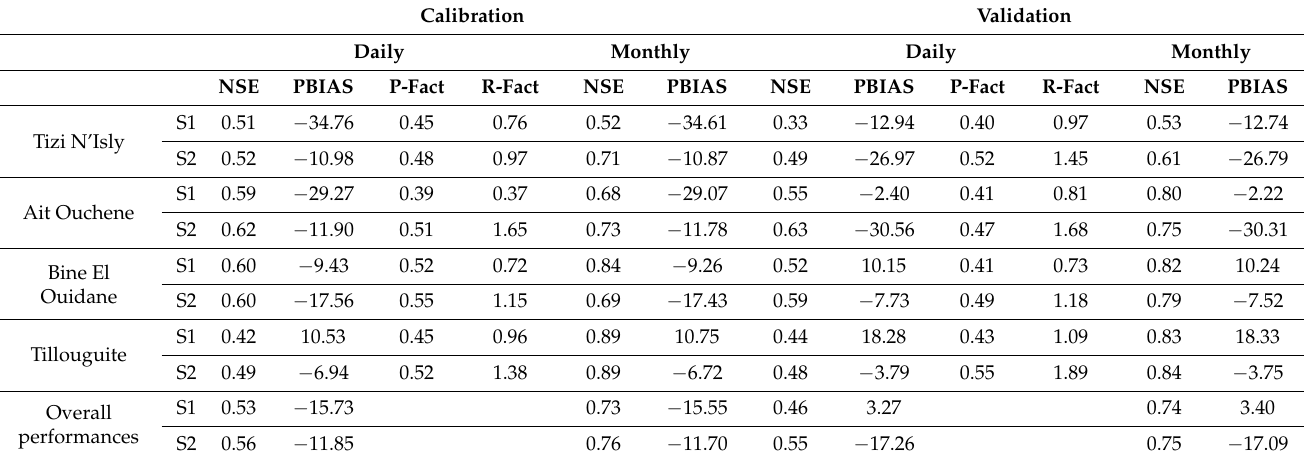
Table 2. Performance criteria of streamflow